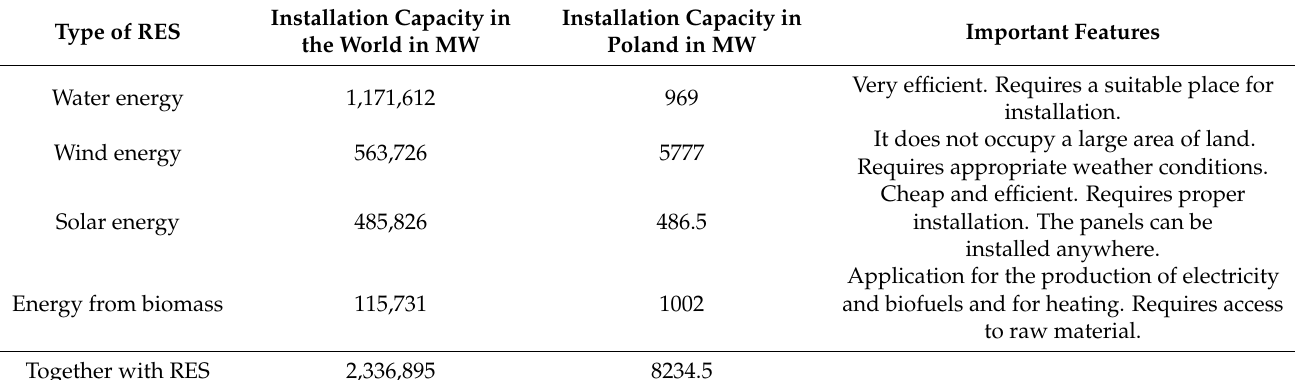
Table 2. Some features of RES in Poland and in the world in 2018 [25,26].